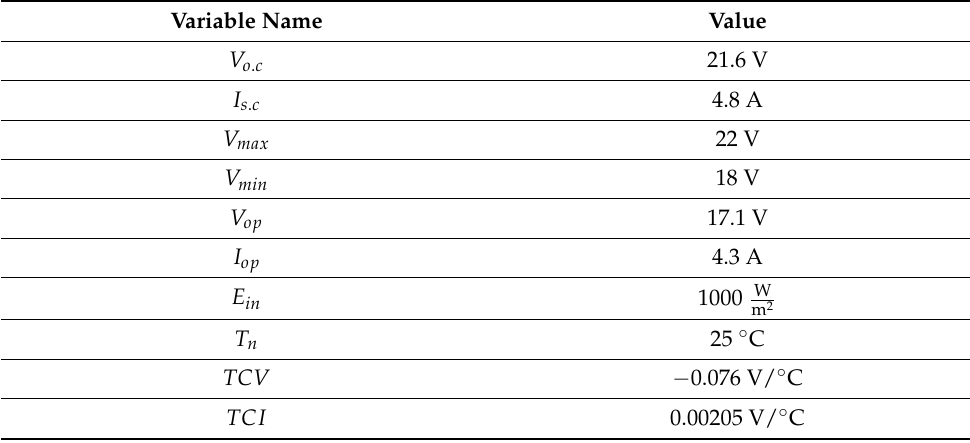
Table 1. Standard parameters of the solar cell model.